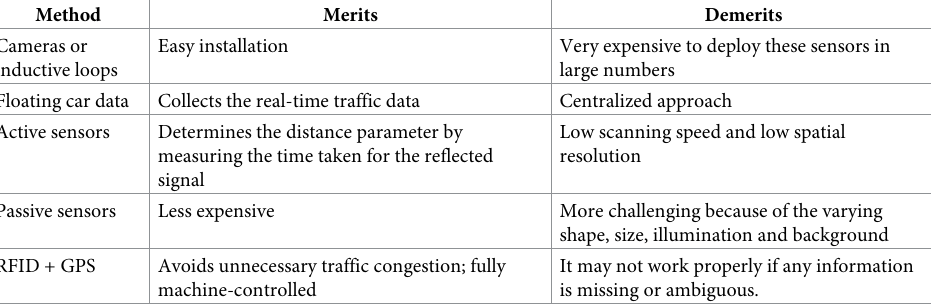
Table 1. Comparison of lane clearance